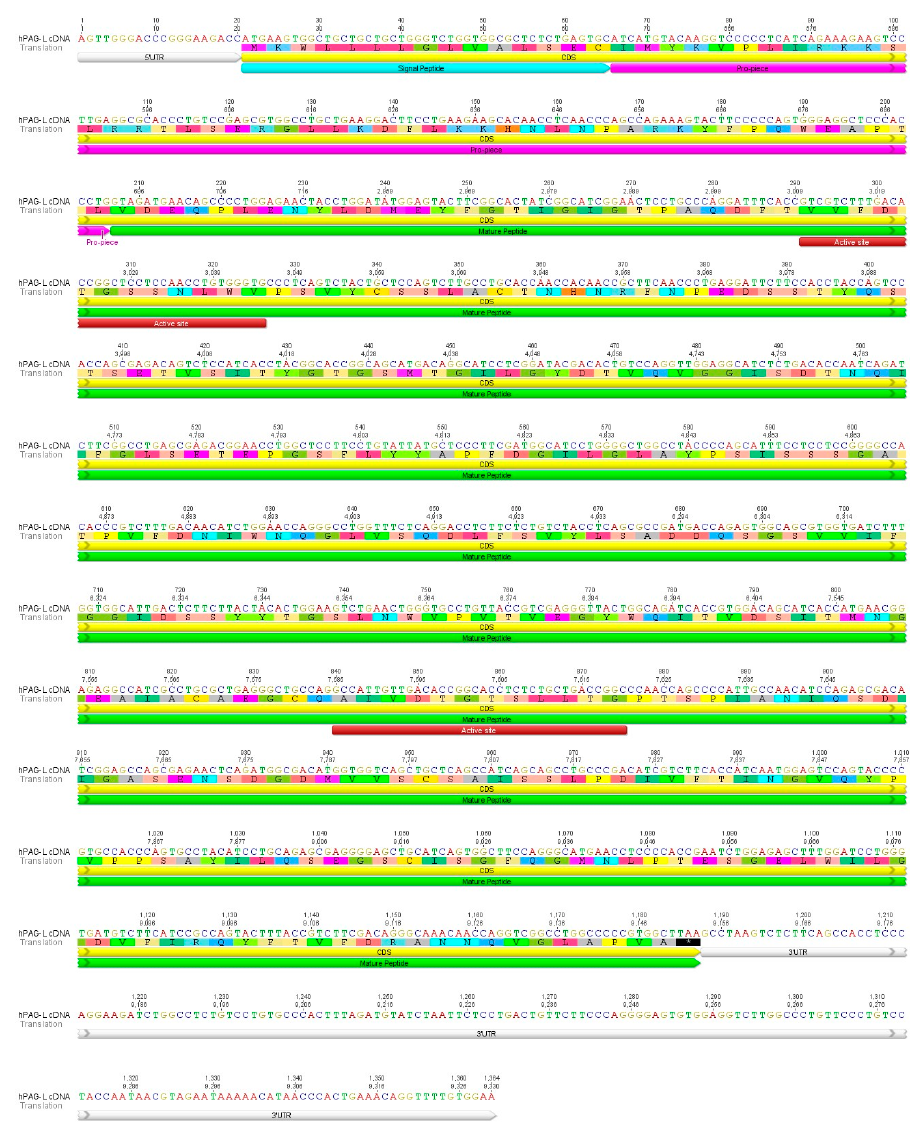
Figure 1. Identified cDNA sequence of 1364 bp human Pregnancy-Associated Glycoprotein-like ( hPAG-L ) encoding full-length 388 amino acids (aa) of polypeptide precursor. 5 ′ - and 3 ′ -untranslated regions (5 ′ UTR and 3 ′ UTR), 15 aa-signal peptide, 47 aa-blocking peptide, 326 aa-mature protein, and active sites creating catalytic clefts are indicated.